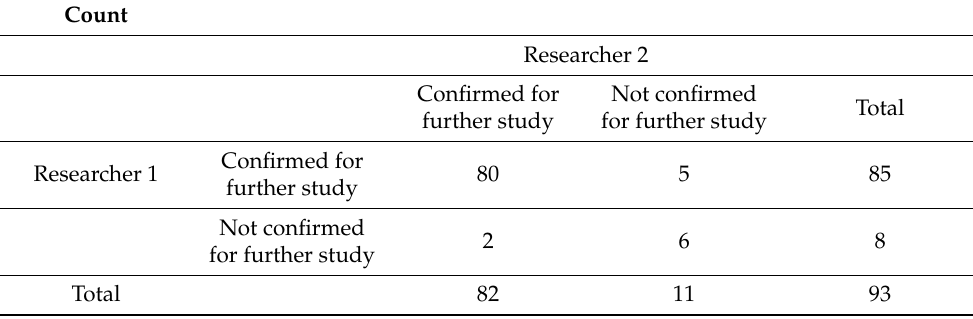
Table 2. The investigators’ RCT studies agreement and disagreement—kappa data